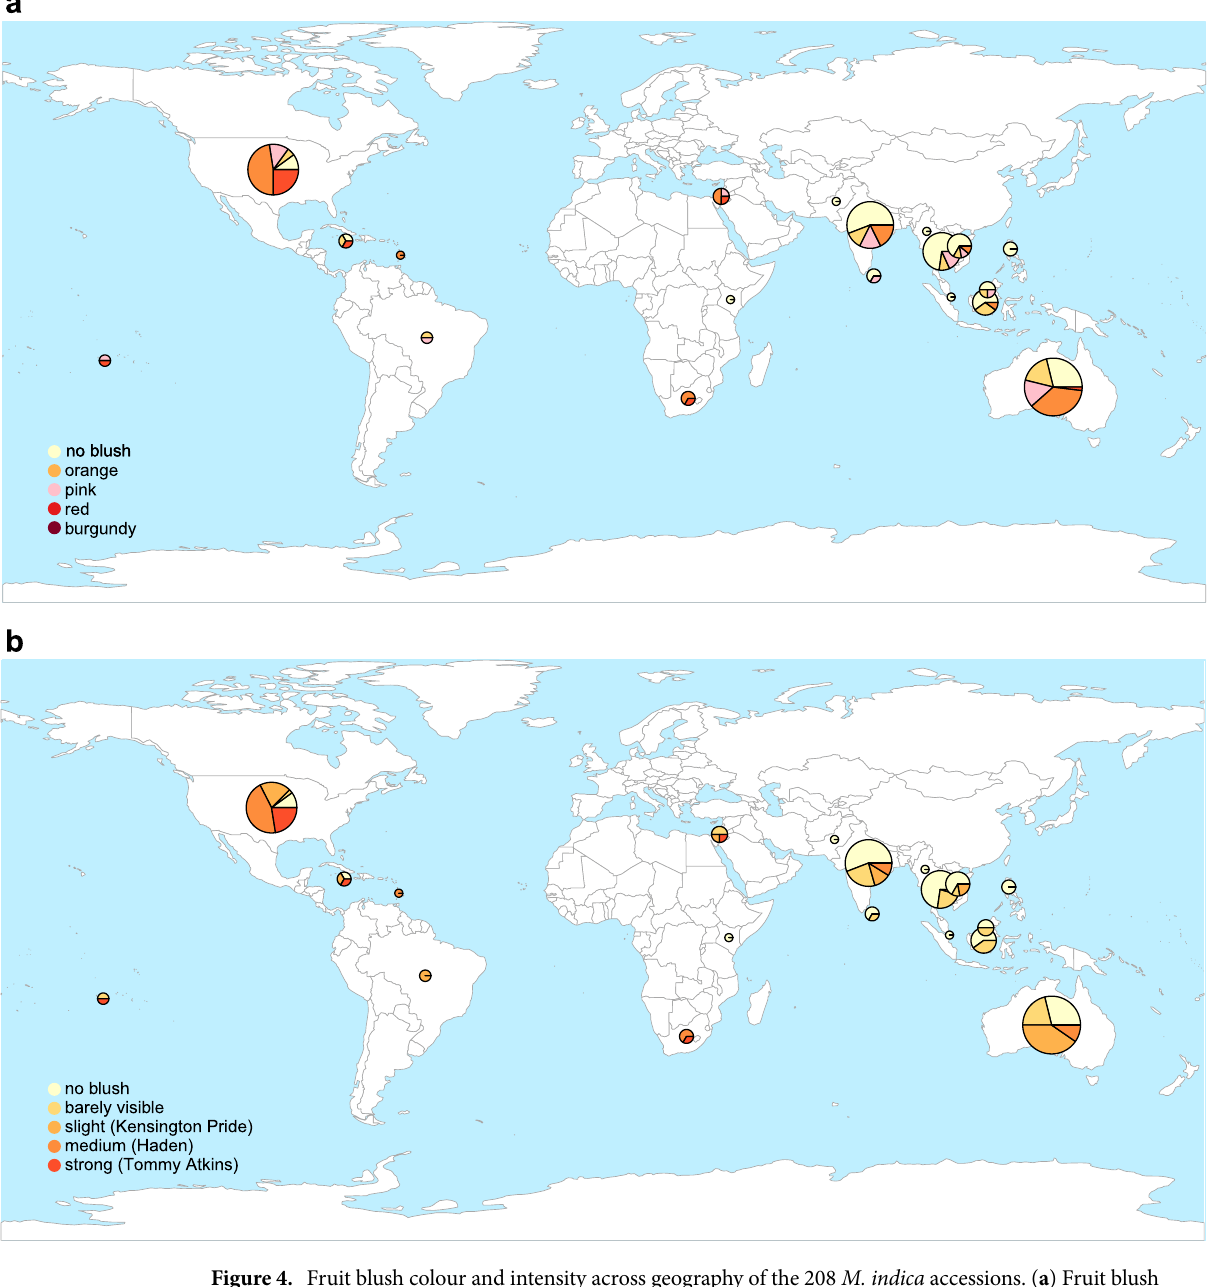
selection models. Our study shows how genetic structure in M. indica can lead to statistical associations between genetic markers and three phenotypic traits measured in this study – trunk circumference, fruit blush colour and intensity. This suggests that the genetic architecture of these horticultural traits contains noise arising from the conflation of phenotypic and historical differences in the Australian mango gene pool. Such noise can create spurious associations that hinder the selection of new cultivars, so we recommend that future studies in mango breeding take this into consideration. Genetic variability and divergence in the Australian mango gene pool can be understood in two ways. On the one hand, accessions imported from different regions are weakly differentiated. On the other hand, genetic clusters are strongly differentiated, implying the existence of clear genetic groups. Results described in Fig. 2 reveal that genetic clusters are distributed across regions, implying that their genetic structure is shared across the